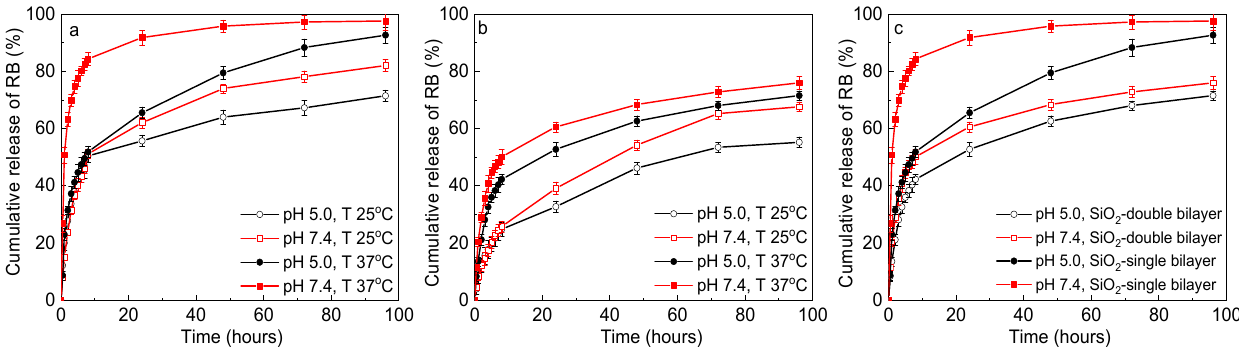
Figure 8. Release of RB at different pH and temperatures from the ( a ) SiO 2 -single bilayer (SiO 2 @PAH/NaALG-g) and ( b ) SiO 2 -double bilayer particles (SiO 2 @PAH/NaALG-g/PAH/NaALG-g). ( c ) For the sake of comparison, the data of the RB release from the SiO 2 -single bilayer (Figure 8a) and the SiO 2 -double bilayer (Figure 8b) particles at pH = 5.0, pH = 7.4 and at 37 °C are also presented. Each point is the mean of three independent measurements, and bars represent standard deviation of means.